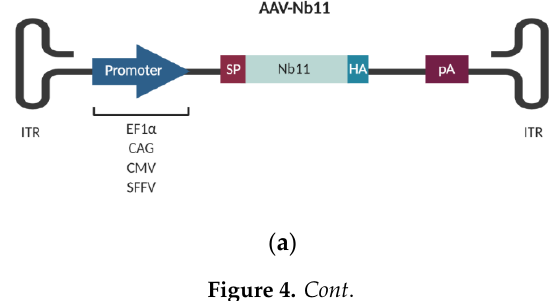
Figure 3. Nb11-mediated restoration of activity markers in mouse primary T cells. T cells were activated with antibodies against CD3 and CD28, in the presence or absence of mPD-L1. Cells were incubated with Nb11, an anti-mPD-L1 control mAb, a control Nb (Ctrl Nb) or without antibodies. After 72 h of incubation, supernatants were collected and levels of ( a ) IL-2 (interleukin 2) and ( b ) IFN ɣ (interferon gamma) were measured by ELISA. Data represent the mean + SEM. Statistical analysis was performed using one-way ANOVA test with Dunnett’s multiple comparison test, using as reference group the third column (activation with antibodies and mPD-L1, without treatment). One representative experiment out of two performed is shown. * p < 0.05; ** p < 0.01; **** p < 0.0001, ns: not